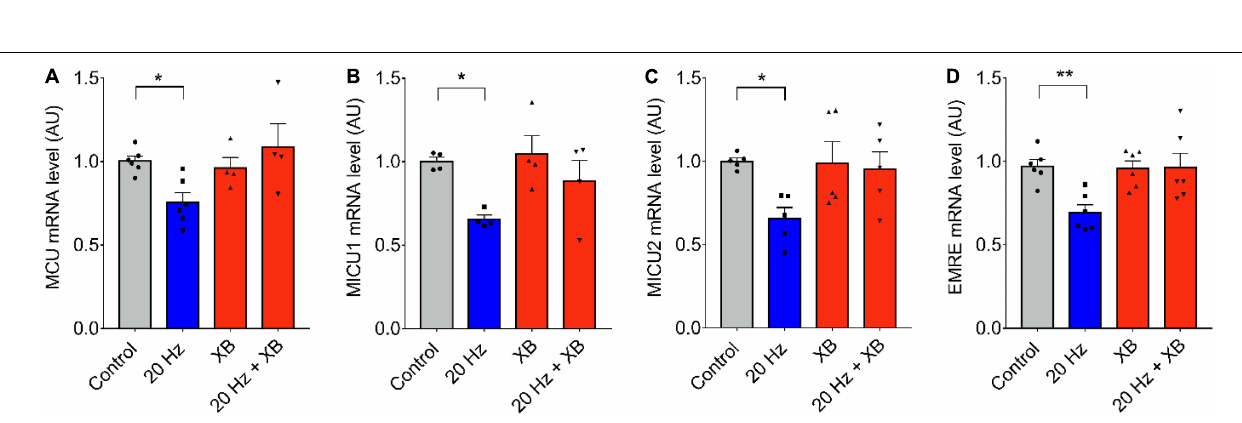
FIGURE 4 | IP3R is involved in low-frequency ES-dependent reduction of mRNA levels of MCU complex. Muscle fibers fdb muscle were pretreated with the IP3R blocker, XB (10 µ M) by 30 min before being electrically stimulated (as in Figure 1 ). The mRNA was extracted 1 h after electrical stimulation. Preincubation with XB prevented the low frequency-dependent reduction in mRNA levels of MCU ( n = 6) (A) , MICU1 ( n = 5) (B) , MICU2 ( n = 5) (C) , and EMRE ( n = 6) (D) . For (C) using the Kruskal–Wallis test with post hoc Dunn’s was applied. Values are presented as mean ± SEM. 18S was used as normalizer. * p < 0.05; ** p < 0.01; *** p < 0.001.